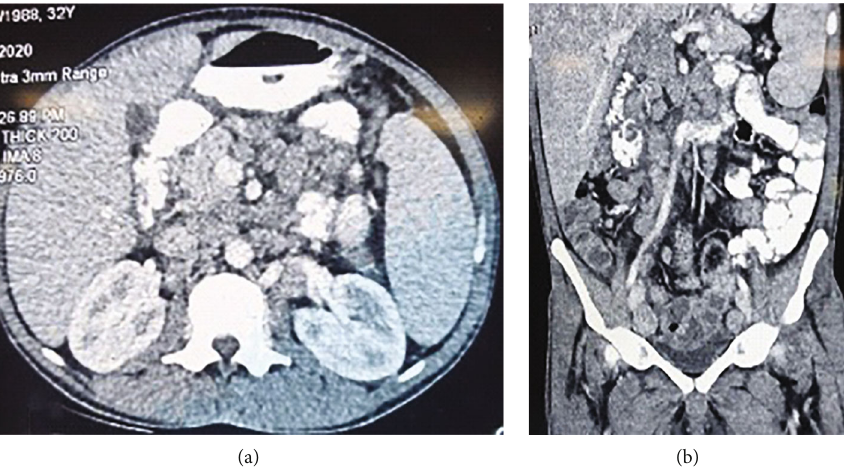
Figure 3: (a) Axial view of CT scan of the abdomen showing hepatosplenomegaly with pre- and para-aortic mesenteric lymphadenopathy; (b) enlarged liver and spleen with multiple intra-abdominal lymphadenopathies.